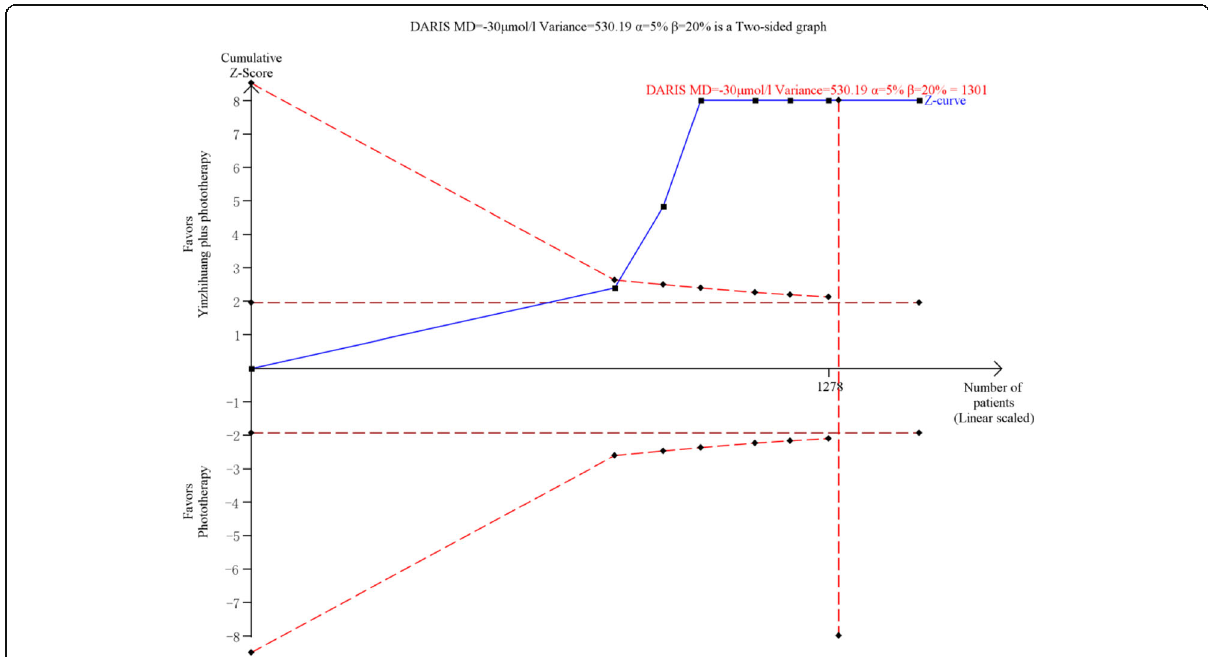
Fig. 4 Trial sequential analysis of total serum bilirubin for Yinzhihuang oral liquid combined with phototherapy versus phototherapy monotherapy. Note: Trial sequential analysis illustrated that the cumulative Z-curve (blue curve) had crossed the monitoring boundaries (red inward sloping curves) and reached the diversity-adjusted required information size (DARIS), which is calculated to be 1301 patients (vertical line) based on a mean difference (MD) of -30umol/L, variance of 530.19, type I error of 5% and type II error of 20%.) of 20%, and diversity (D) of